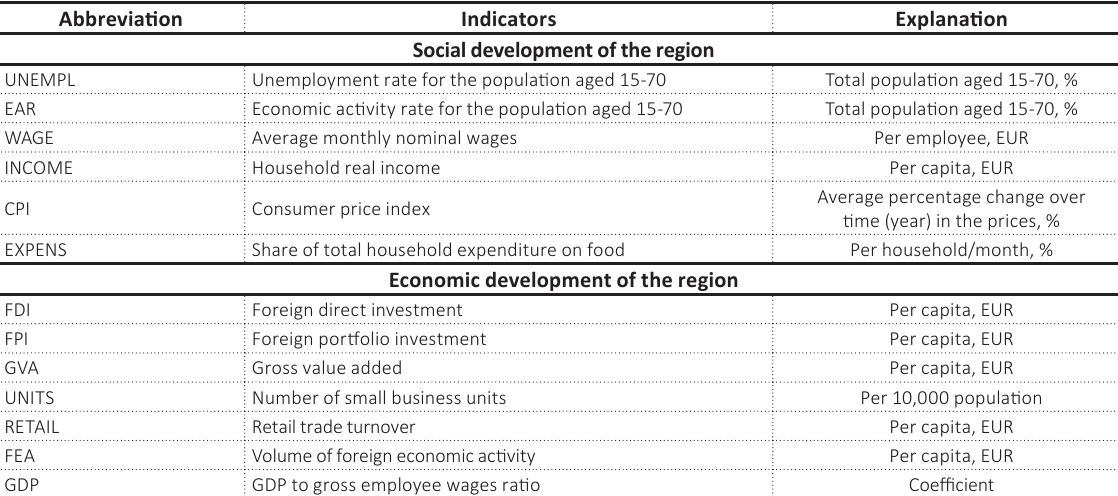
Source: Compiled by the